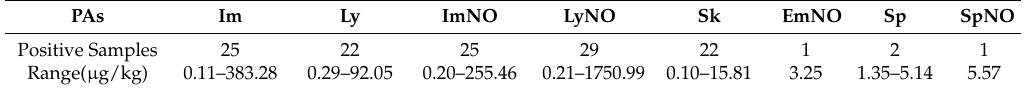
Figure 6. ( A ) The distribution of each major detected PA in A. capillaris samples. X: Batch number of samples, Y: detected major individual PA, Z: content of PAs in different samples. ( B ) the chemical structures of five detected PAs. Table 2. The frequency and content range of individual PAs in A. capillaris